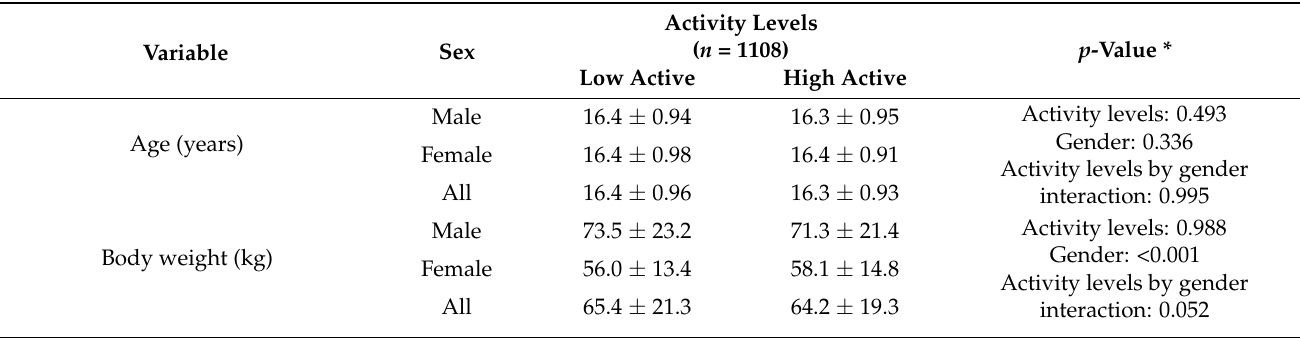
Table 5. Multivariable analysis for selected anthropometric and lifestyle variables stratified by sex and activity levels while controlling for